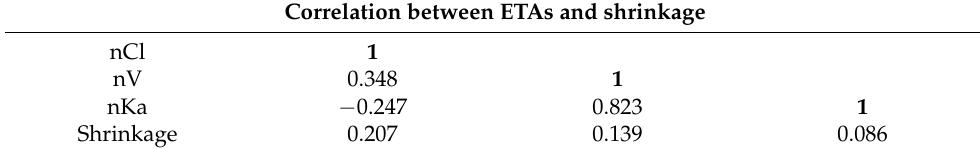
Variances (diagonal) are in bold; nCl, nV and nK a are the random components of the model (ETAs). The BSVs, expressed as coefficient of variation (CV%) using Equation (2), were 10.9, 22.1 and 100.1% for nCl, nV and nKa, respectively. The variance, CV% and shrinkage of nDrink (the random component of tvDrink, not included in the variance–covariance matrix) were 1542.23, 24% and 15%, respectively.